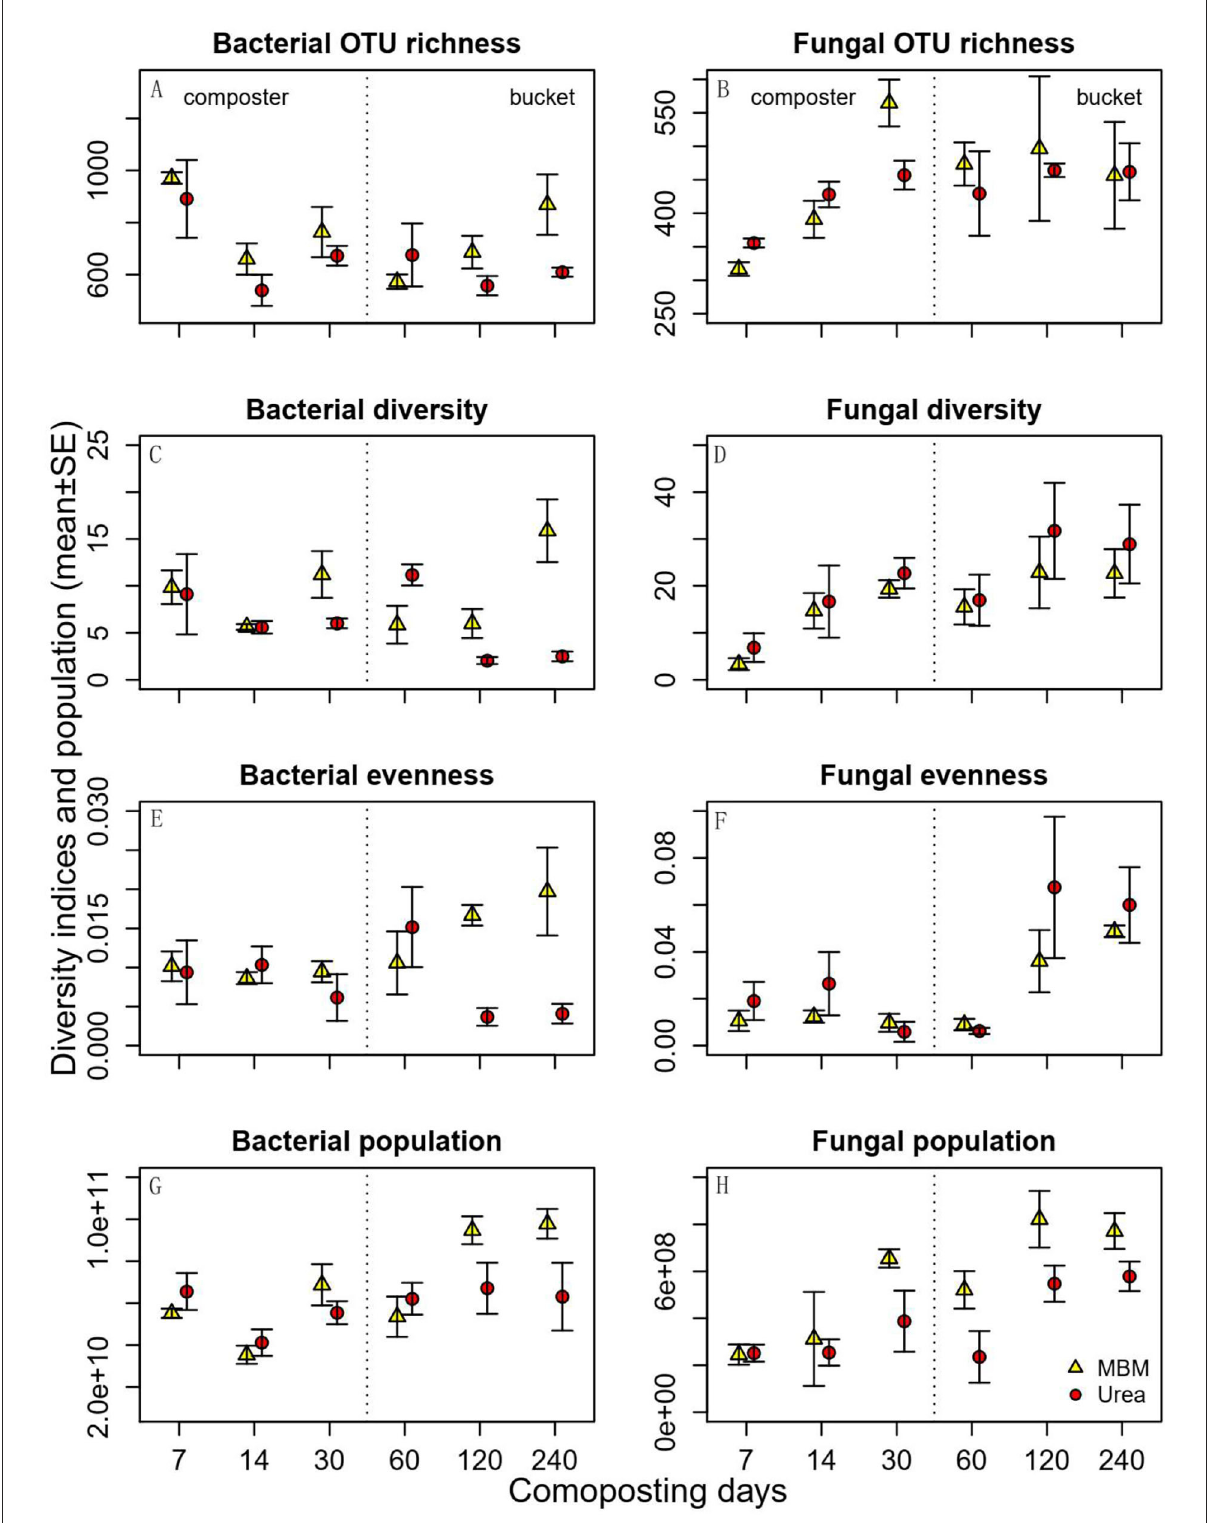
FIGURE3 Predicted bacterial (left panels) and fungal (right panels) OTU richness, diversity, evenness, and population density (qPCR estimated ITS2 copy number per gram of dry soil) in the compost of meat and bone meal (MBM) and urea treatments (urea) and time (X axis). Error bars represent standard